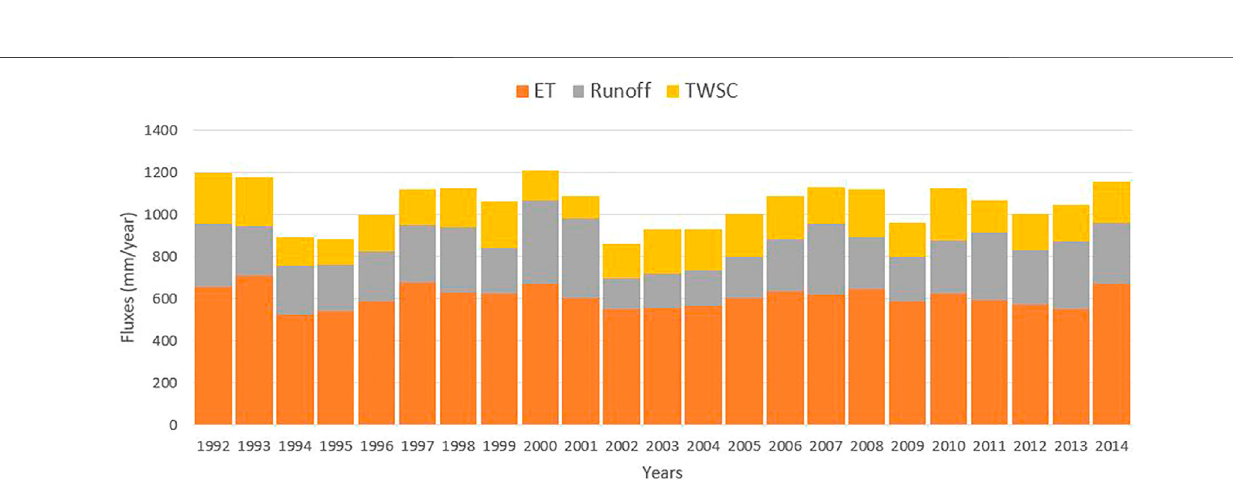
Frontiers in Earth Science |